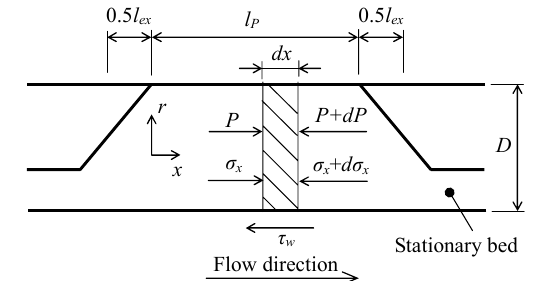
Fig.1 Pressure within a plug in horizontal pipe l P